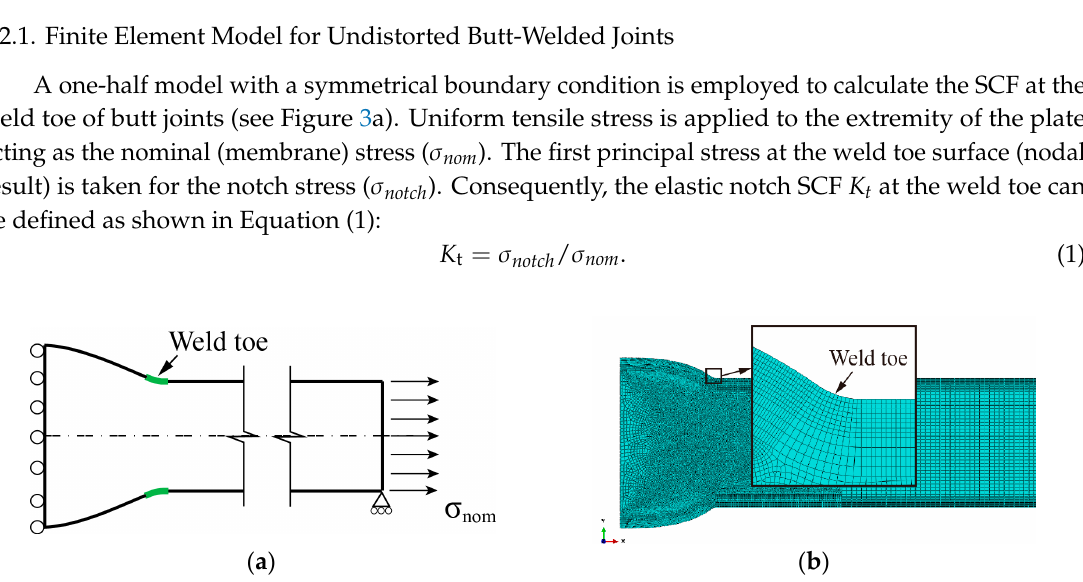
( a ) ( b ) Figure 4. Convergence analysis of the mesh: ( a ) the first principal stresses under different numbers of elements: flank angle 35 θ=  ; ( b ) normalized stresses under different numbers of elements. 2.2.2. Finite Element Model for Distorted Butt-Welded Joints When it comes to distorted butt-welded joints, the simulation should be consistent with the course of the fatigue test as much as possible to catch the SCF and clamping-induced stress at the weld toe of the joint. Hence, a two-step FE analysis with the same material and mesh parameters as undistorted butt-welded joints (see Section 2.2.1) is carried out for distorted joints under fatigue test conditions, as illustrated in Figure 5. In detail, the left clamping area is fully fixed corresponding to a specimen gripped on one side [27]. In the first step, hydraulic grips, which are modelled with rigid bodies, straighten the distorted joints on the other side. Subsequently, uniform tensile stress ( σ nom ) is applied to the extremity of the plate after clamping. Frictionless contact between the grip and plate is assumed. ( a )